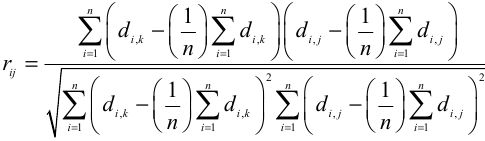
Fig. 1. The basic algorithm of the proposed MCDM